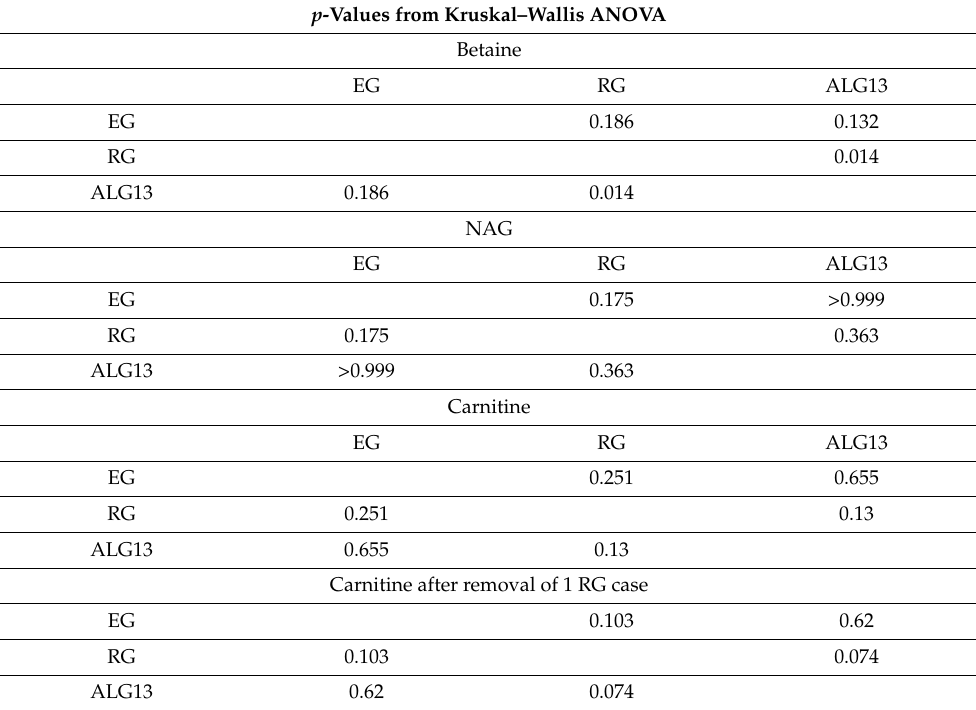
Table 2. The p -values from Kruskal–Wallis ANOVA showing the statistical differences in the relative intensities of betaine, NAG, and carnitine between the RG and EG groups and three ALG13 cases. p -Values from Kruskal–Wallis ANOVA Betaine EG RG ALG13 EG 0.186 0.132 RG